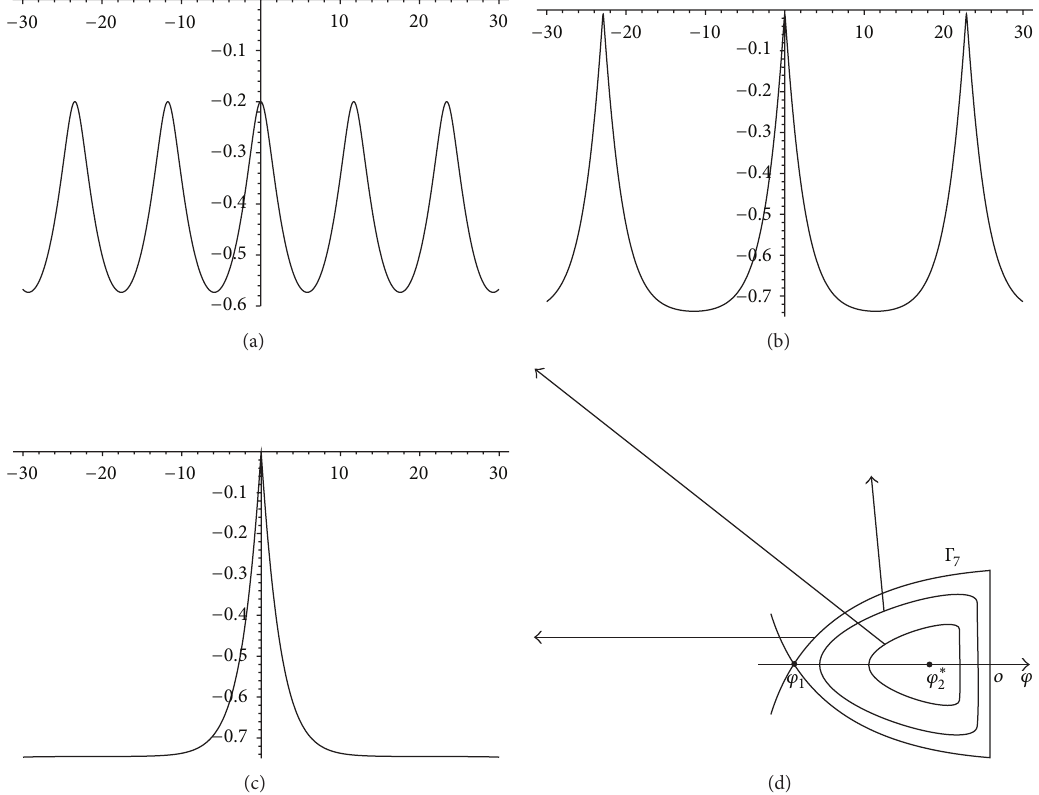
Figure 11: The simulation of integral curves of (40) when 𝛼 = 𝛽 = 𝛾 = 1 , 𝑐 = 2 , 𝑔 = 4√5/27 , (a) initial value 𝜑(0) = −0.2 , (b) initial value 𝜑(0) = −0.01 , and (c) initial value 𝜑(0) = −0.00001